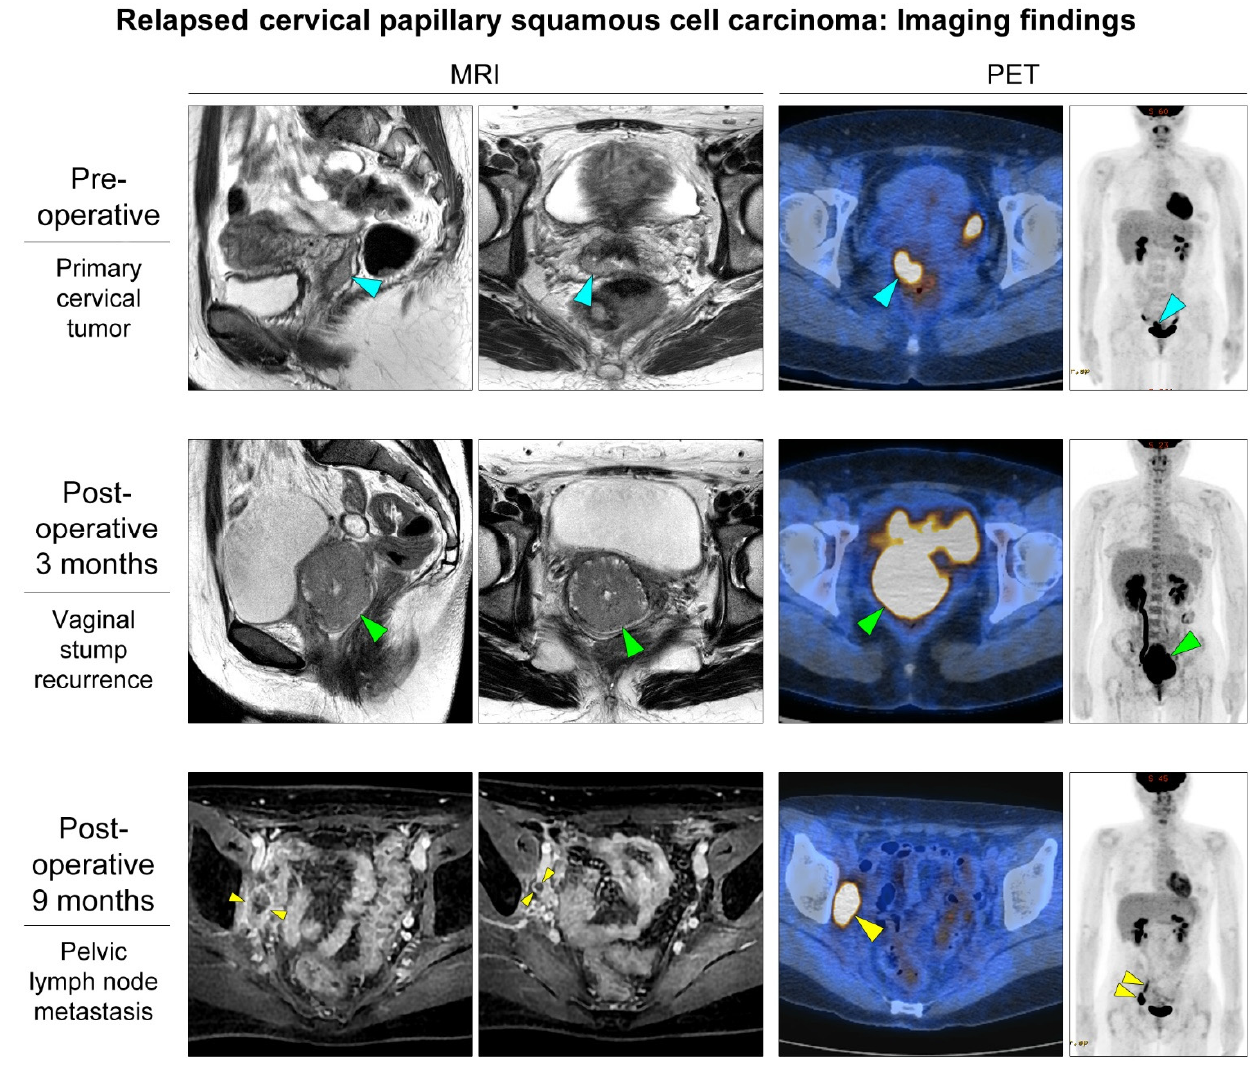
Figure 1. Imaging findings of a 33-year-old woman with a history of abnormal cervicovaginal cytology and high-risk human papillomavirus infection. Preoperative sagittal and axial magnetic resonance imaging (MRI) reveal an exophytic cervical mass (blue arrowheads) that seem to protrude into the vaginal lumen. The parametrium, lymph node, and adnexa are unremarkable. Positron emission tomography (PET) reveal a hypermetabolic lesion in the right lateral aspect of the uterine cervix (blue arrowhead), which is also shown in the maximum intensity projection image. She underwent radical hysterectomy with bilateral pelvic lymph node dissection and was diagnosed with early-stage cervical squamous cell carcinoma. Three months postoperatively, follow-up MRI and PET detect a recurrent tumor on the anterior wall of the vaginal stump (green arrowheads). She received chemoradiation therapy and achieved complete remission. However, pelvic lymph node metastases are developed nine months postoperatively (yellow arrowheads). Axial MRI and PET show two enlarged and hypermetabolic lymph nodes in the right obturator